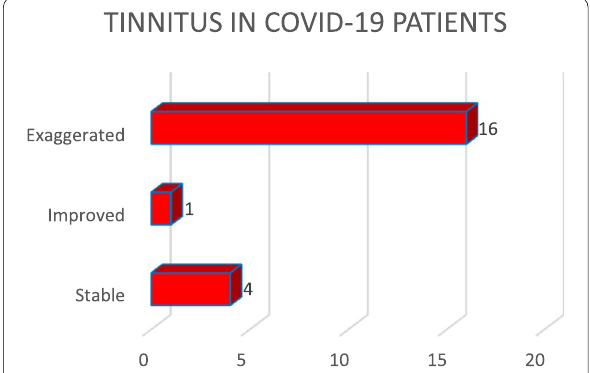
Fig. 2 Experience of tinnitus among COVID-19 patients